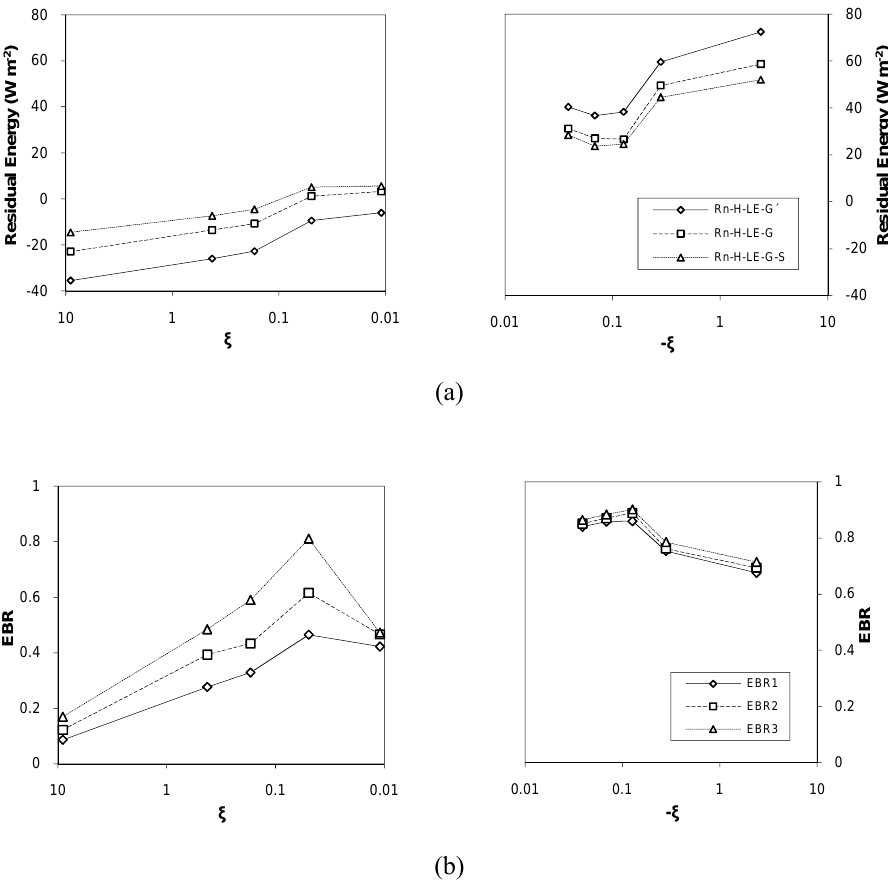
Fig. 4. Effect of the atmospheric stability ξ on: (a) the residual energy, (b) the energy balance ratio. Left-hand plots correspond to stable conditions, and right-hand plots correspond to unstable conditions. Values indicate averages in each range of ξ